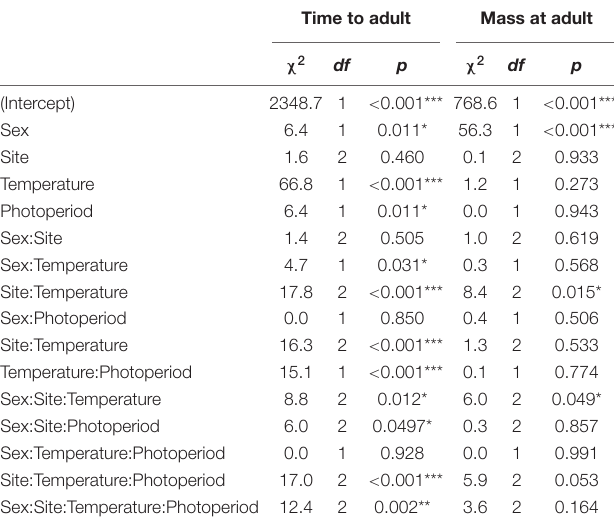
TABLE 1 | Wald 3 ANOVA for linear mixed effects models of grasshopper time to adulthood (days) and mass at adulthood (g). Time to adult Mass at